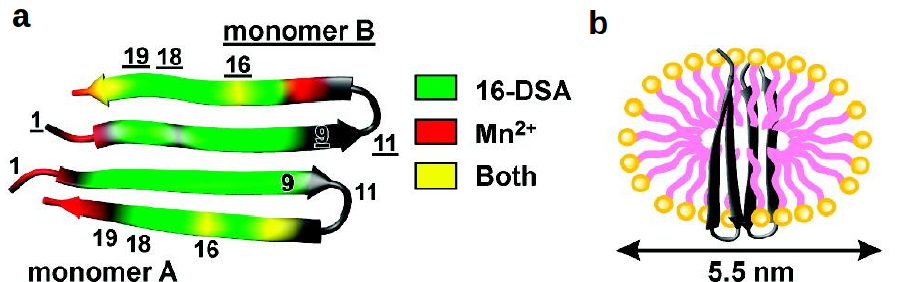
Figure 5. ( a ) Arenicin-2 PREs: highly affected residues by 16-DSA (green), Mn 2+ (red) and both probes (yellow), in case of the black colored residues the PREs were below the thresholds. The proposed orientation of arenicin-2 and its interaction with a DPC micelle, including the effect of arginine 16 on the membrane’s curvature is shown in ( b